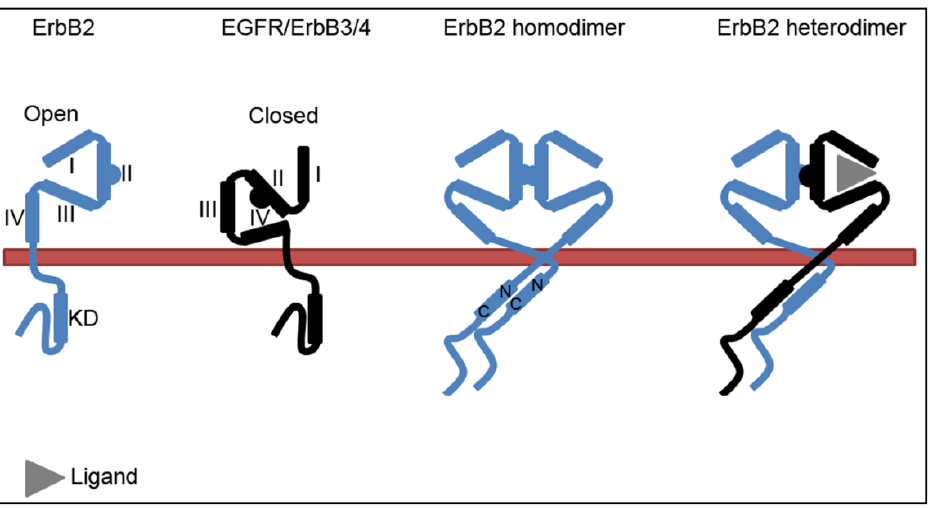
Figure 1. Conformation of monomeric and dimeric ErbB-proteins. While the extracellular region of ErbB2 constitutively adopts an open conformation, EGFR, ErbB3, and ErbB4 depend on ligand binding to change from a closed to an open conformation and to participate in dimerization. In dimers, the kinase domains (KDs) interact in an asymmetric fashion where the C-terminal of one KD interacts with the N-terminal of the other. I-IV refer to the respective domains in the extracellular region of the